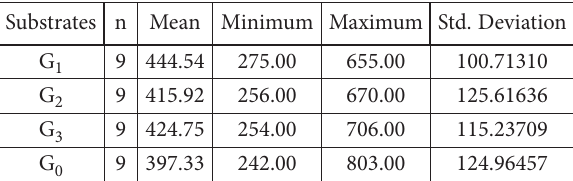
Table 1. The salinity (EC) values (μS cm –1 ) of substrates Substrates n Mean Minimum Maximum Std. Deviation